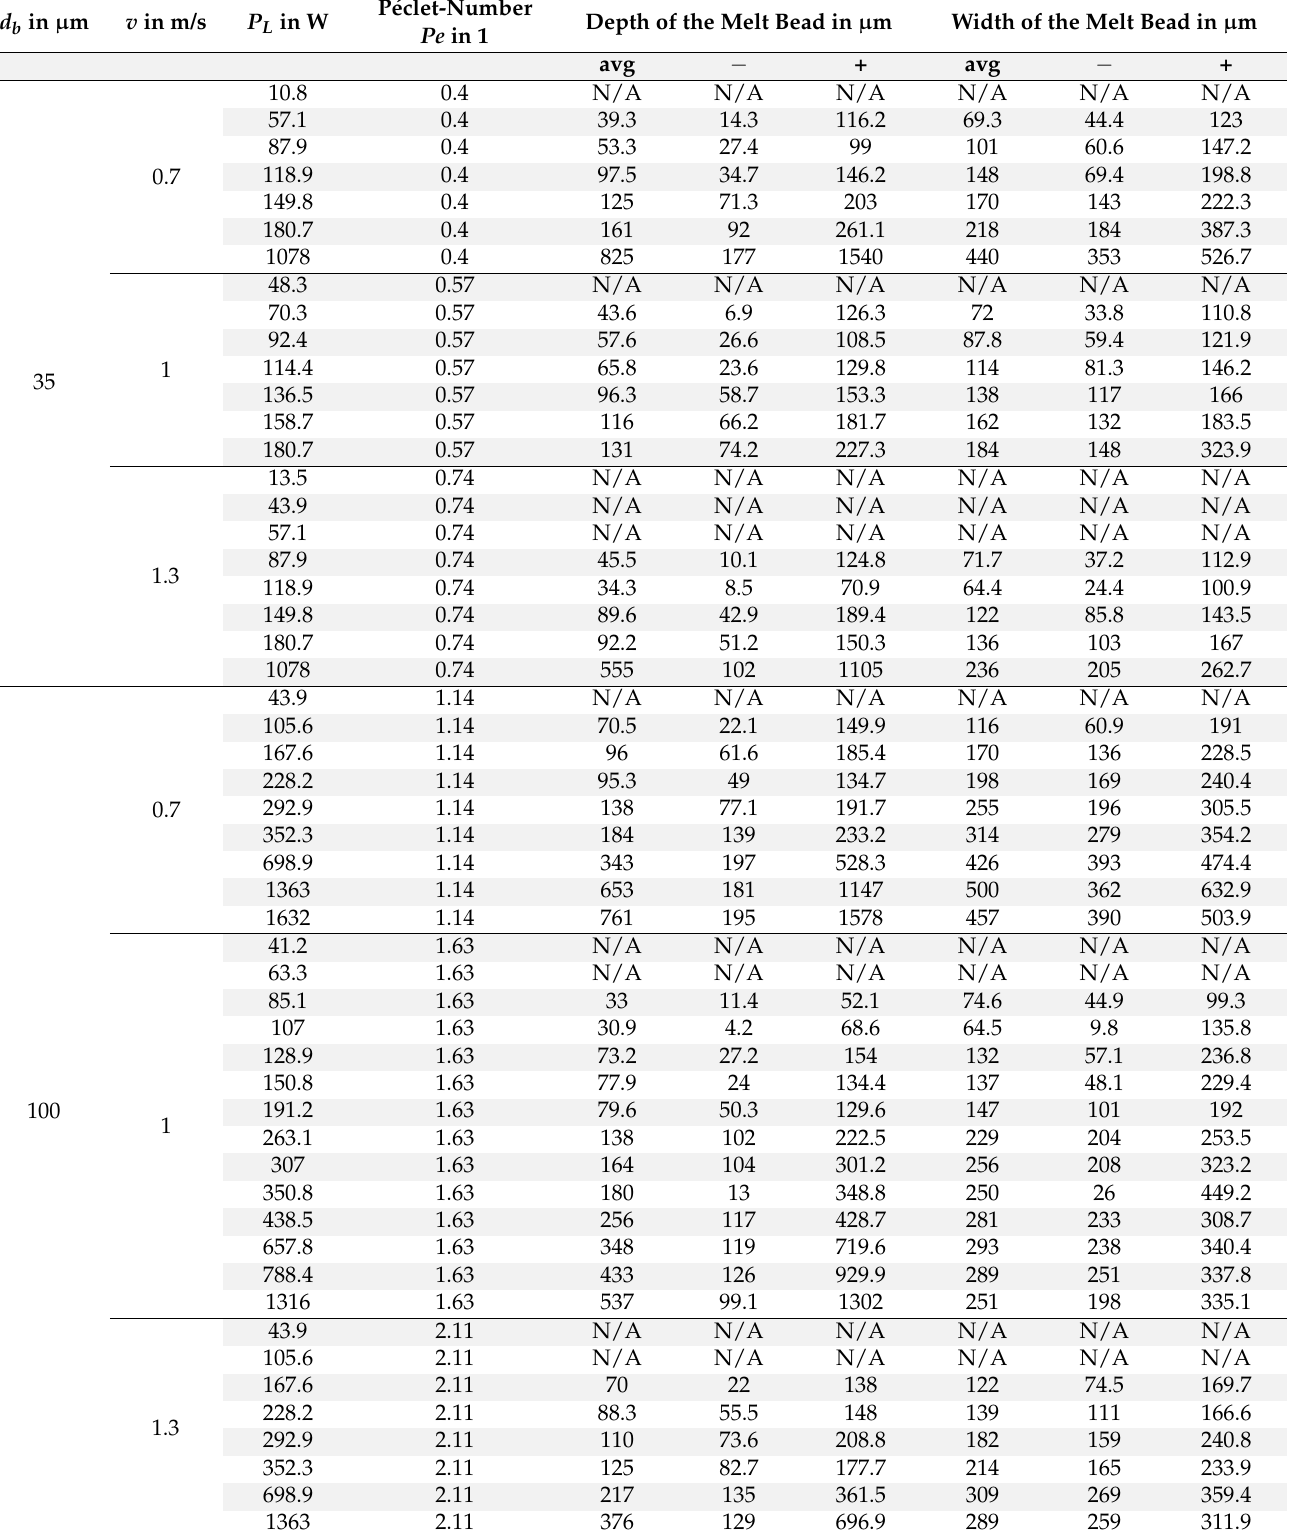
Table A2. Experimental plan and detailed results of the P é clet numbers, the cross-sectional depths, and widths of the melt beads of the investigation. Each parameter set was repeated three times and at least six melt beads were analyzed per parameter